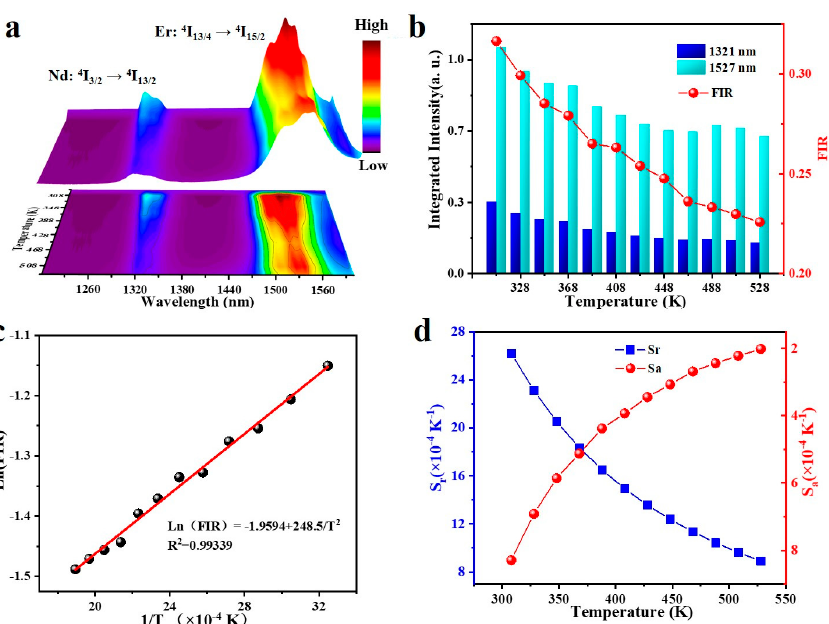
Figure 4. ( a ) Photoluminescence emission spectra curve of the Ba 2 LuF 7 : Nd 3+ /Yb 3+ /Er 3+ nanoparticles covering 308–528 K temperature range. Integrated upconversion intensities at 1321 nm and 1527 nm. ( b ) Temperature dependence of the fluorescence ratio values of thermally coupled energy levels. Dependence of FIR values of the ( b ) thermally coupled levels on temperature. ( c ) Ln(FIR) as an inverse absolute function of inverse absolute temperature. ( d ) The temperature function of the thermal coupling level of nanomaterials based on the fitting of S a and S r values. S a and S r values are based on the ( d ) thermally coupled levels as a function of